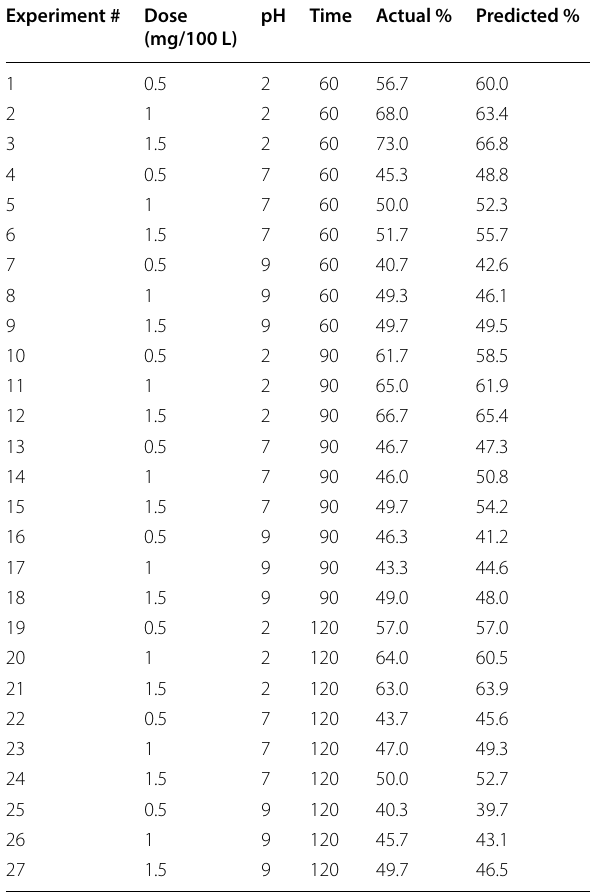
Table 4 Full factorial experimental matrix for fluoride removal displayed in